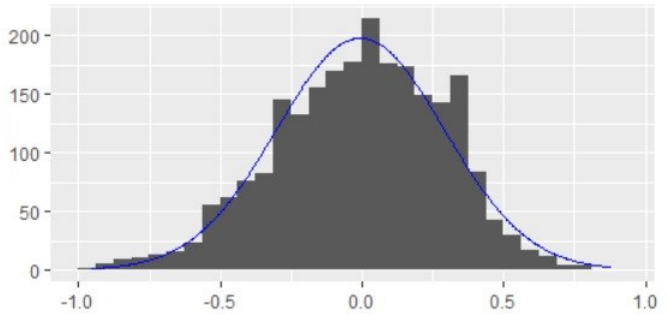
Figure 5. Histogram of the discrete time series B H ( t ) .